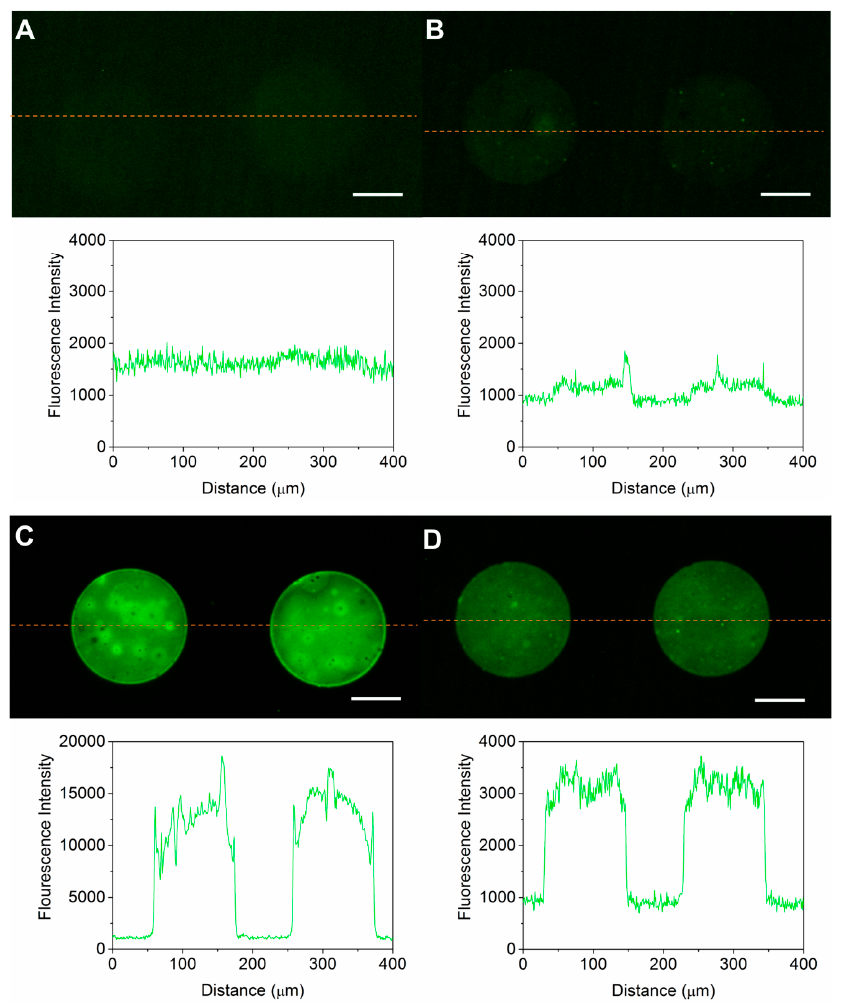
Figure 5. Fluorescence images and corresponding line scans showing the quality of the micro contact printing ( μ CP) process using PLL-FITC by different procedures. All the results were obtained with the same settings of the microscope and electron multiplying charge coupled device (EMCCD) camera. ( A ) Micropatterns on an O 2 plasma-treated PDMS substrate; ( B ) micropatterns on a glass